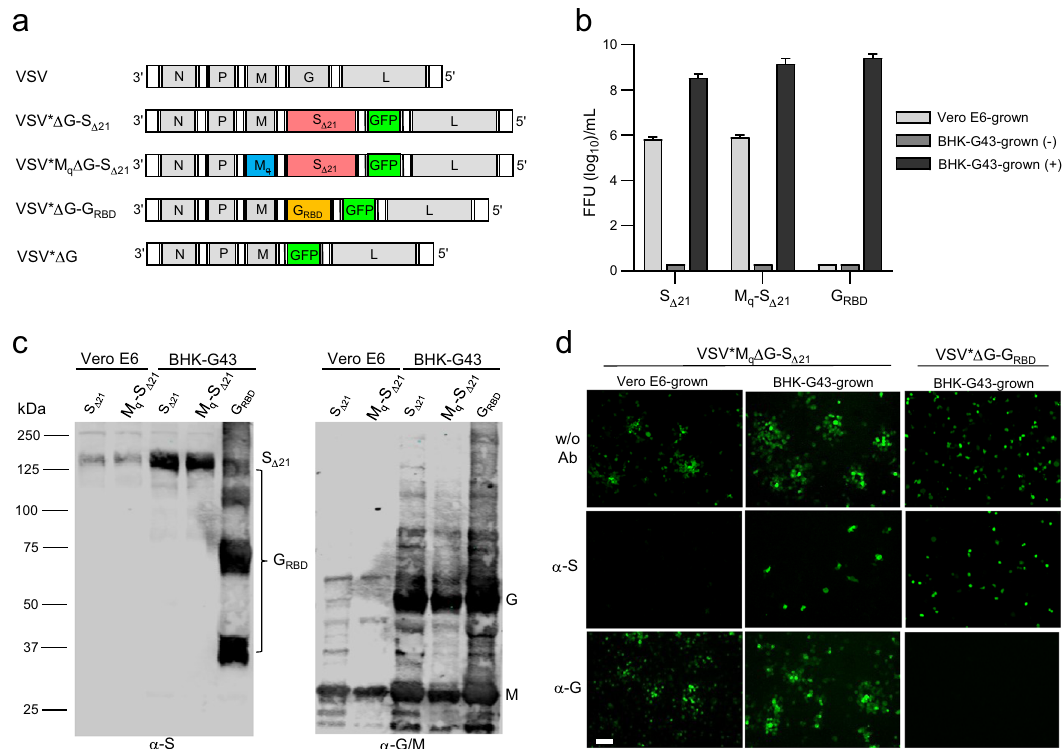
Fig. 1 Generation and characterization of VSV-vectored COVID-19 vaccine candidates. a Genome maps of recombinant VSV vectors. The original VSV contains fi ve transcription units encoding the N, P, M, G, and L genes. The VSV vector was modi fi ed by replacing the G gene with a modi fi ed SARS-CoV-2 spike gene and by inserting an additional transcription unit encoding GFP. M q denotes a quadruple mutant M gene encoding an M protein that lacks host shut-off activity. G RBD denotes a synthetic membrane protein presenting the receptor-binding domain (RBD) of the SARS-CoV-2 spike protein. b Virus yield on Vero E6 and BHK-G43 cells. Vero E6 cells, BHK-G43 cells expressing the VSV glycoprotein ( + ), and BHK-G43 cells lacking VSV glycoprotein expression ( − ) were infected with either VSV*M q Δ G-S Δ 21 (S Δ 21 ), VSV*M q Δ G-S Δ 21 (M q -S Δ 21 ), or VSV* Δ G-G RBD (G RBD ) using 0.1 ffu/cell. At the 24 hours pi, infectious virus released into the cell culture was titrated on Vero E6 cells. Mean values and standard deviations of 3 infection experiments are shown. c Western blot analysis of recombinant VSV vector particles. VSV* Δ G-S Δ 21 (S Δ 21 ) and VSV*M q Δ G-S Δ 21 (M q -S Δ 21 ) were propagated on both Vero E6 and BHK-G43 cells, while VSV* Δ G-G RBD (G RBD ) were propagated only on BHK-G43 helper cells. At 24 hours pi, the virus particles were concentrated from the cell culture supernatant by ultracentrifugation and dissolved in SDS sample buffer. The viral proteins were separated by SDS-PAGE under non-reducing conditions and blotted onto nitrocellulose membrane. Antigens were detected with a COVID-19 convalescent serum ( α -S) and a rabbit polyclonal immune serum directed to the VSV G and M proteins ( α -G/M). The blots were derived from the same experiment and were not further processed. d Inhibition of virus entry using neutralizing antibodies directed to either the VSV G protein or the SARS-CoV-2 spike protein. Vero E6 cells were inoculated in the absence or presence of the indicated neutralizing antibodies with VSV*M q Δ G-S Δ 21 produced on either Vero E6 or BHK- G43 cells and with VSV* Δ G-G RBD grown on BHK-G43 cells. Infected cells were detected 24 h pi taking advantage of the GFP reporter. Bar = 100 fl uorescent protein (GFP) was inserted into the vector genome downstream of the S gene (Fig. 1a). A second vaccine candidate, VSV*M q Δ G-S Δ 21 , was generated by replacing the matrix (M) gene in the VSV* Δ G-S Δ 21 vector genome with the modi fi ed M q gene, which encodes an M protein devoid of host shut-off activity 16 . designed by inserting the synthetic G RBD gene into the VSV vector genome. G RBD encodes a composite membrane protein made up of the N-terminal VSV G signal peptide, the receptor-binding domain (RBD) of the SARS-CoV-2 S protein, and the C-terminal part of the VSV G protein comprising the VSV G stem, transmembrane, and cytosolic domains. BHK-G43 cells are transgenic BHK-21 cells, which express the VSV G protein in a regulated manner 17 . All three VSV-vectored vaccines, VSV* Δ G-S Δ 21 , VSV*M q Δ G-S Δ 21 , and VSV* Δ G-G RBD repli- cated on these cells to high titers if the expression of the VSV glycoprotein was induced ( + ), but none of them propagated on them in the absence of VSV glycoprotein expression (-) (Fig. 1b). VSV* Δ G-S Δ 21 and VSV*M q Δ G-S Δ 21 also replicated on Vero E6 cells, viruses (Fig. 1c, α -G/M blot). The S Δ 21 protein was detected with an